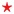
Square wave potential measurements in potential range 1 V to -0.55 V in LiTFSI-PC electrolyte showing in a: the strain ε (2nd-3th cycles) of CFS-PPy/DBS (black line) and CFS-PPy/TF (red line) with potential E (dashed) against time t (frequency, 0.0025 Hz). At frequencies 0.0025 Hz to 0.1 Hz, the maximum strain of CFS-PPy/DBS (black, ■) and CFS-PPy/TF (red, ★) against logarithmic scale of frequency are shown in (b). The obtained charge densities Q from each chronopotentiogram shown in c: strain ε against the charge density Q. The dashed lines in c represent linear fits and are shown just as visual guides.